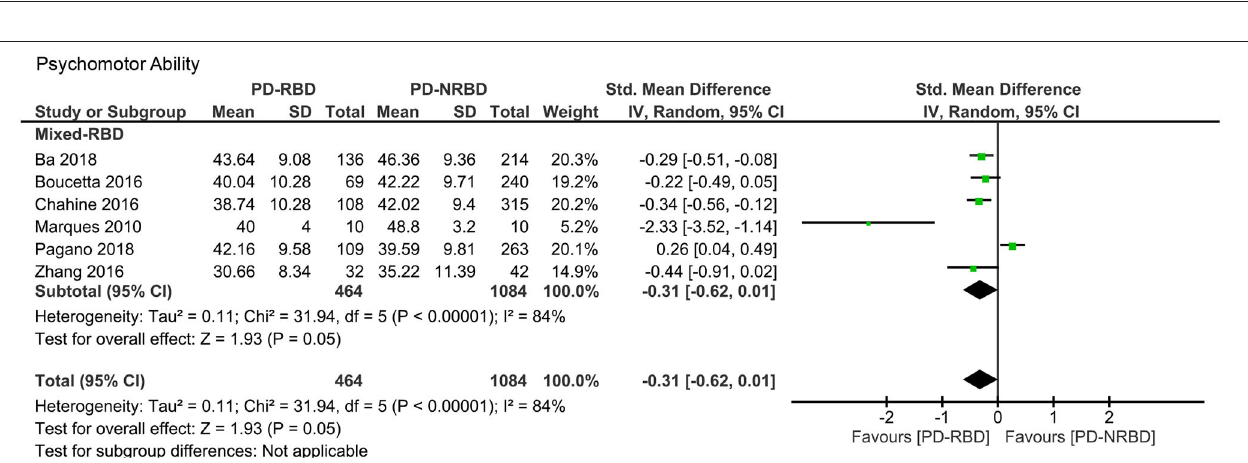
FIGURE 7 | Forest plot for visuospatial/constructional ability with subtotals by the diagnosis of rapid eye movement sleep behavior disorder (RBD) displaying effect size calculated using a random-effects model. SD , standard deviation; Std. Mean Difference , standardized mean difference; CI , confidence interval.